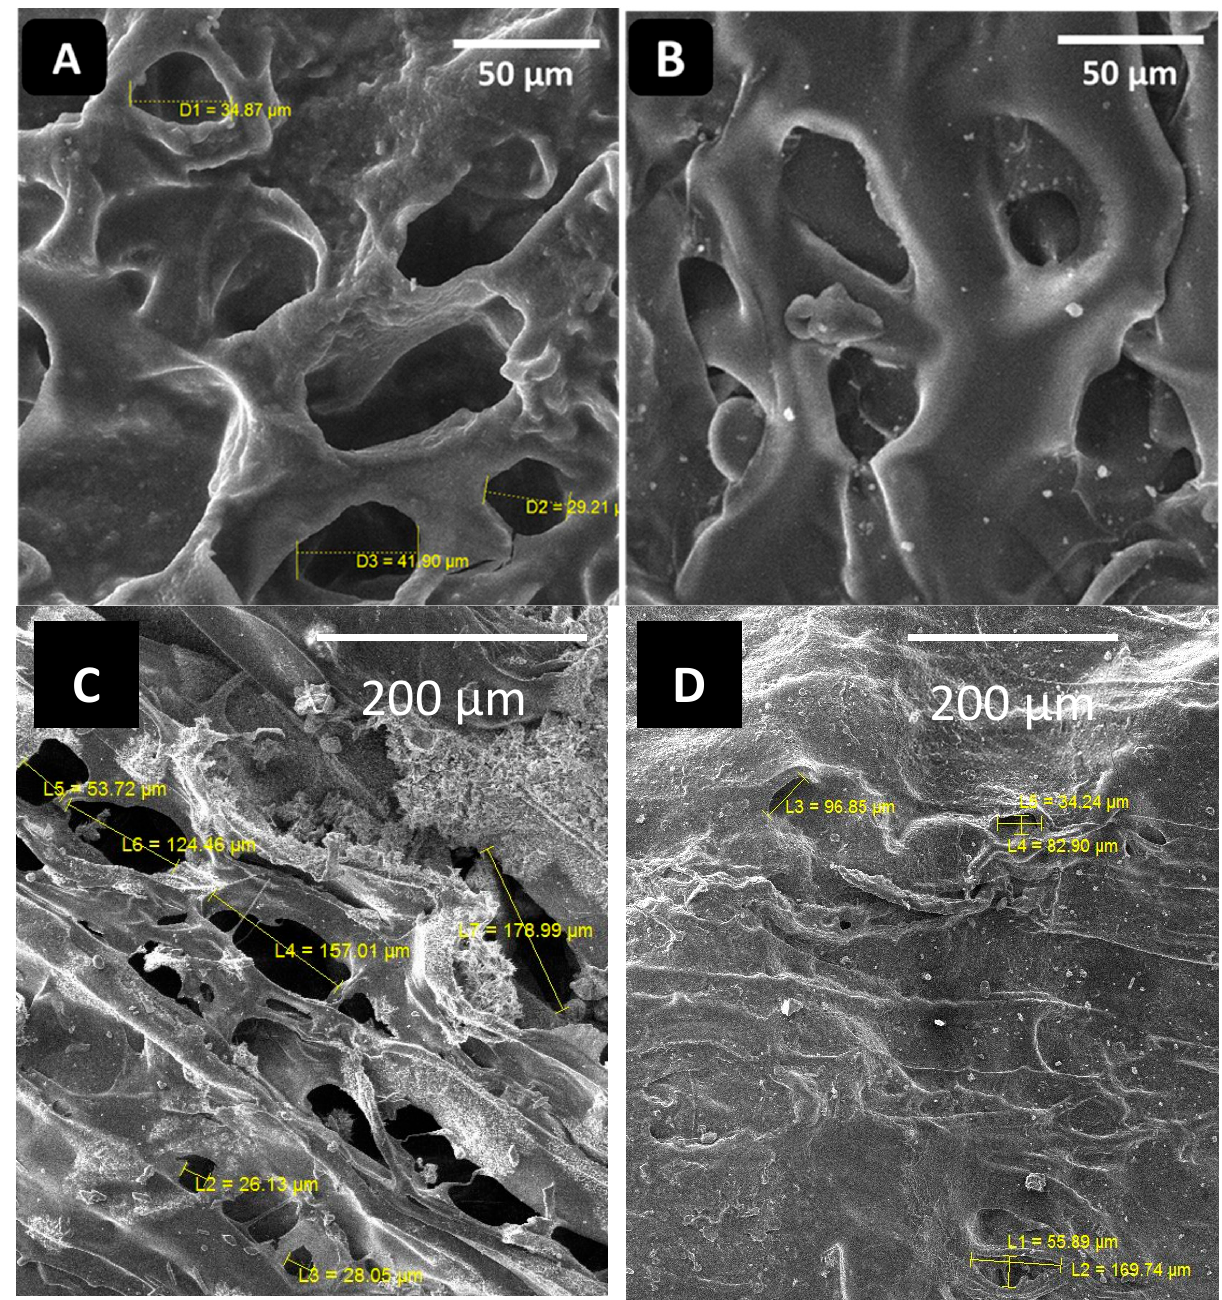
Figure 1. SEM images of ( A ) 80CS20CHI hydrogel and ( B ) 80CS20CHIGar hydrogel ( C ) 67CS33CHI hydrogel and ( D ) 67CS33CHIGar hydrogel.